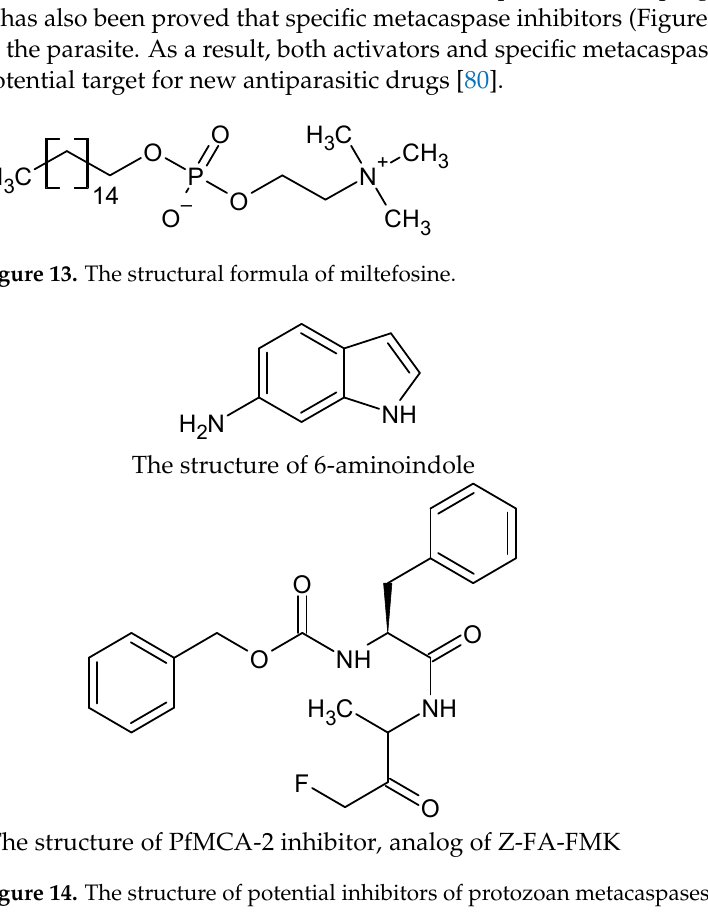
Figure 14. The structure of potential inhibitors of protozoan metacaspases .